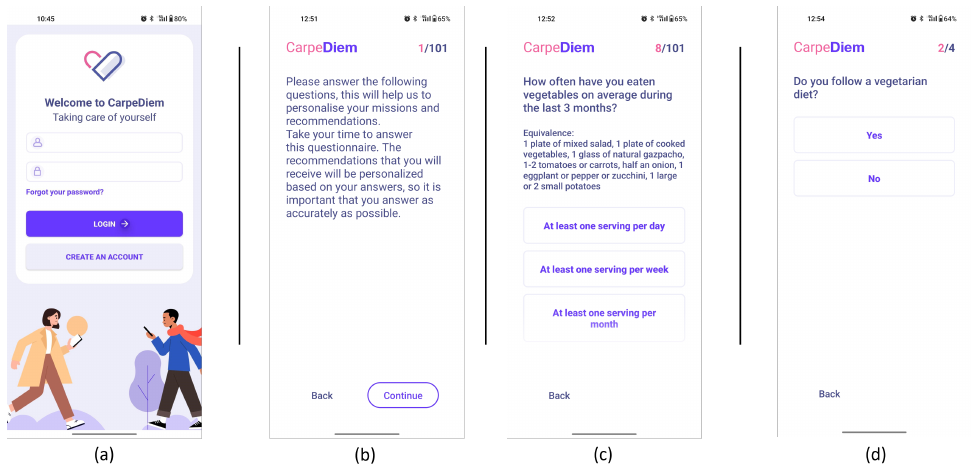
Figure 3. Screenshots from the CarpeDiem app showing user sign-in and questionnaire profil- ing. ( a ) User login. ( b ) Questionnaire information. ( c ) Modified FFQ questionnaire. ( d ) Dietary preference